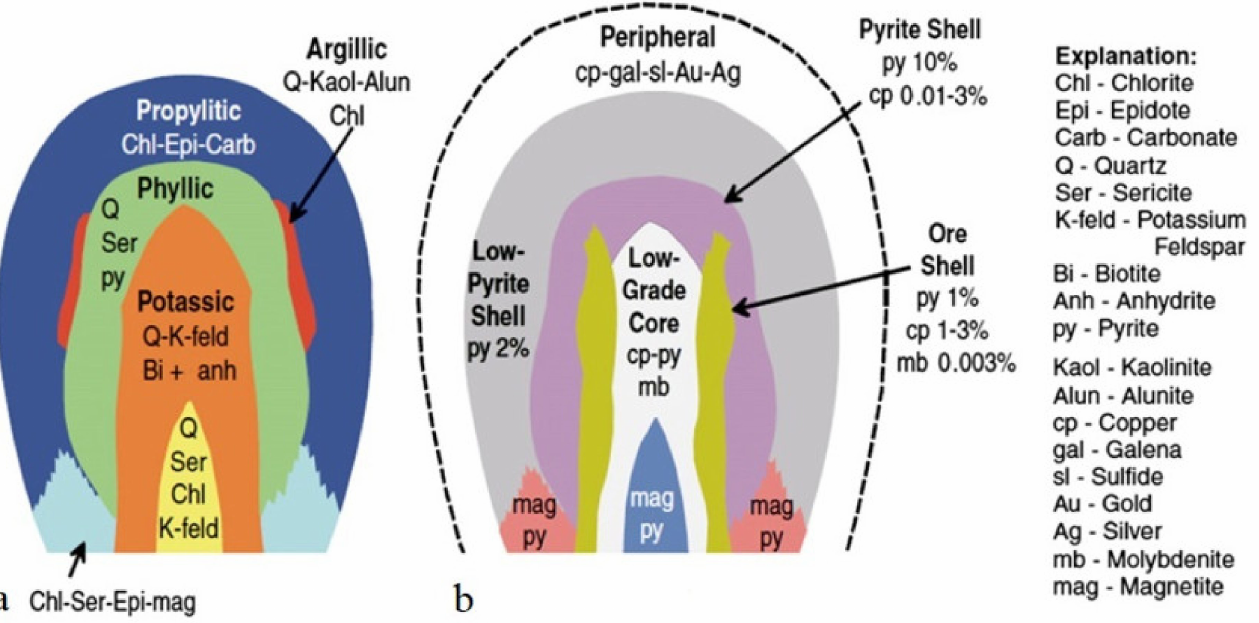
Figure 3. Alteration zones associated with porphyry-Cu deposit (modified after Reference [90]): ( a ) schematic cross section of alteration zones; ( b ) schematic cross section of ores associated with each alteration